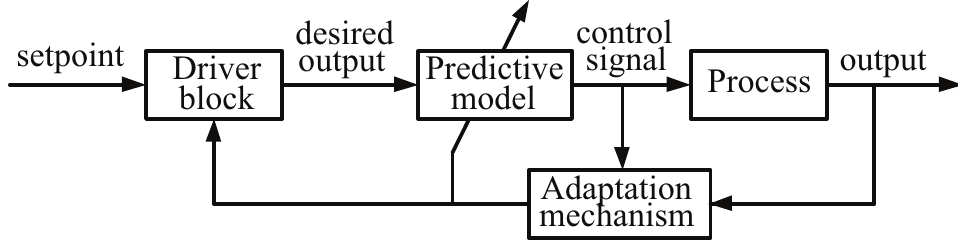
Figure 1. Global scheme of the Adaptive Predictive Control strategy